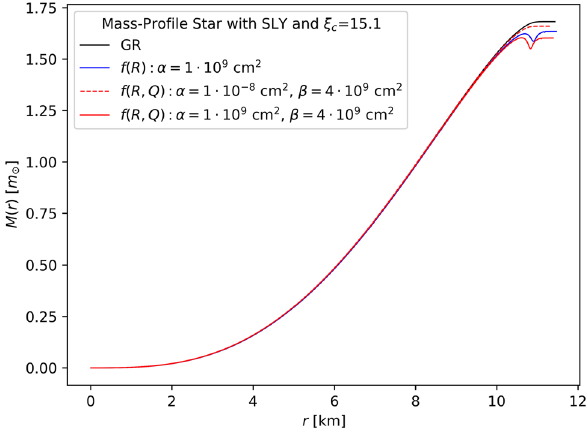
Fig. 18 Metric function M ( r ) as a function of the radial coordinate r , for a neutron star with a central density ξ c = 15 . 1 and the SLy